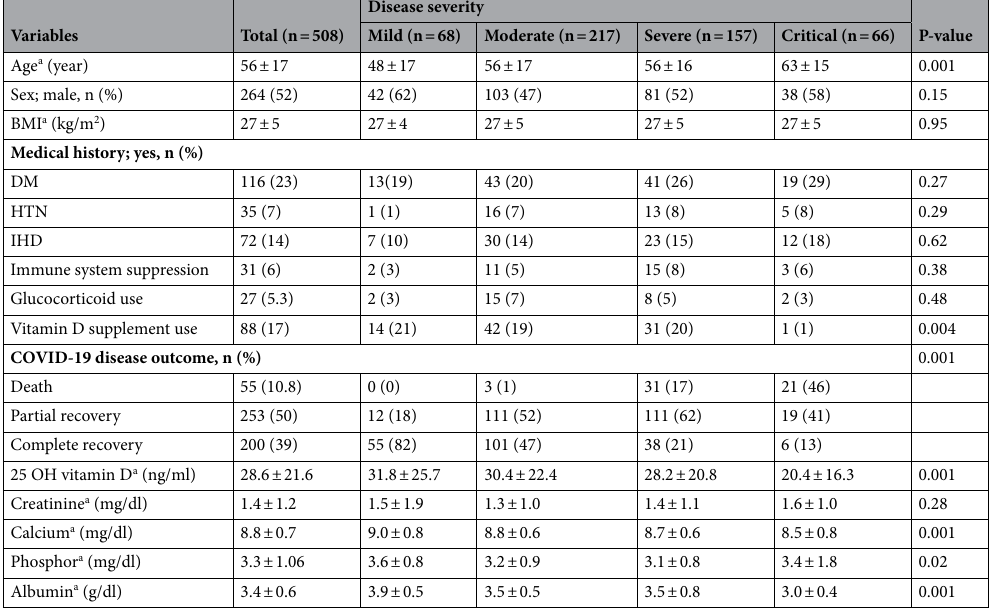
Table 1. Relationship between demographic and medical parameters with the severity of COVID-19 disease. DM diabetes mellitus, HTN hypertension, IHD ischemic heart disease, BMI body mass index. a Mean ± SD.